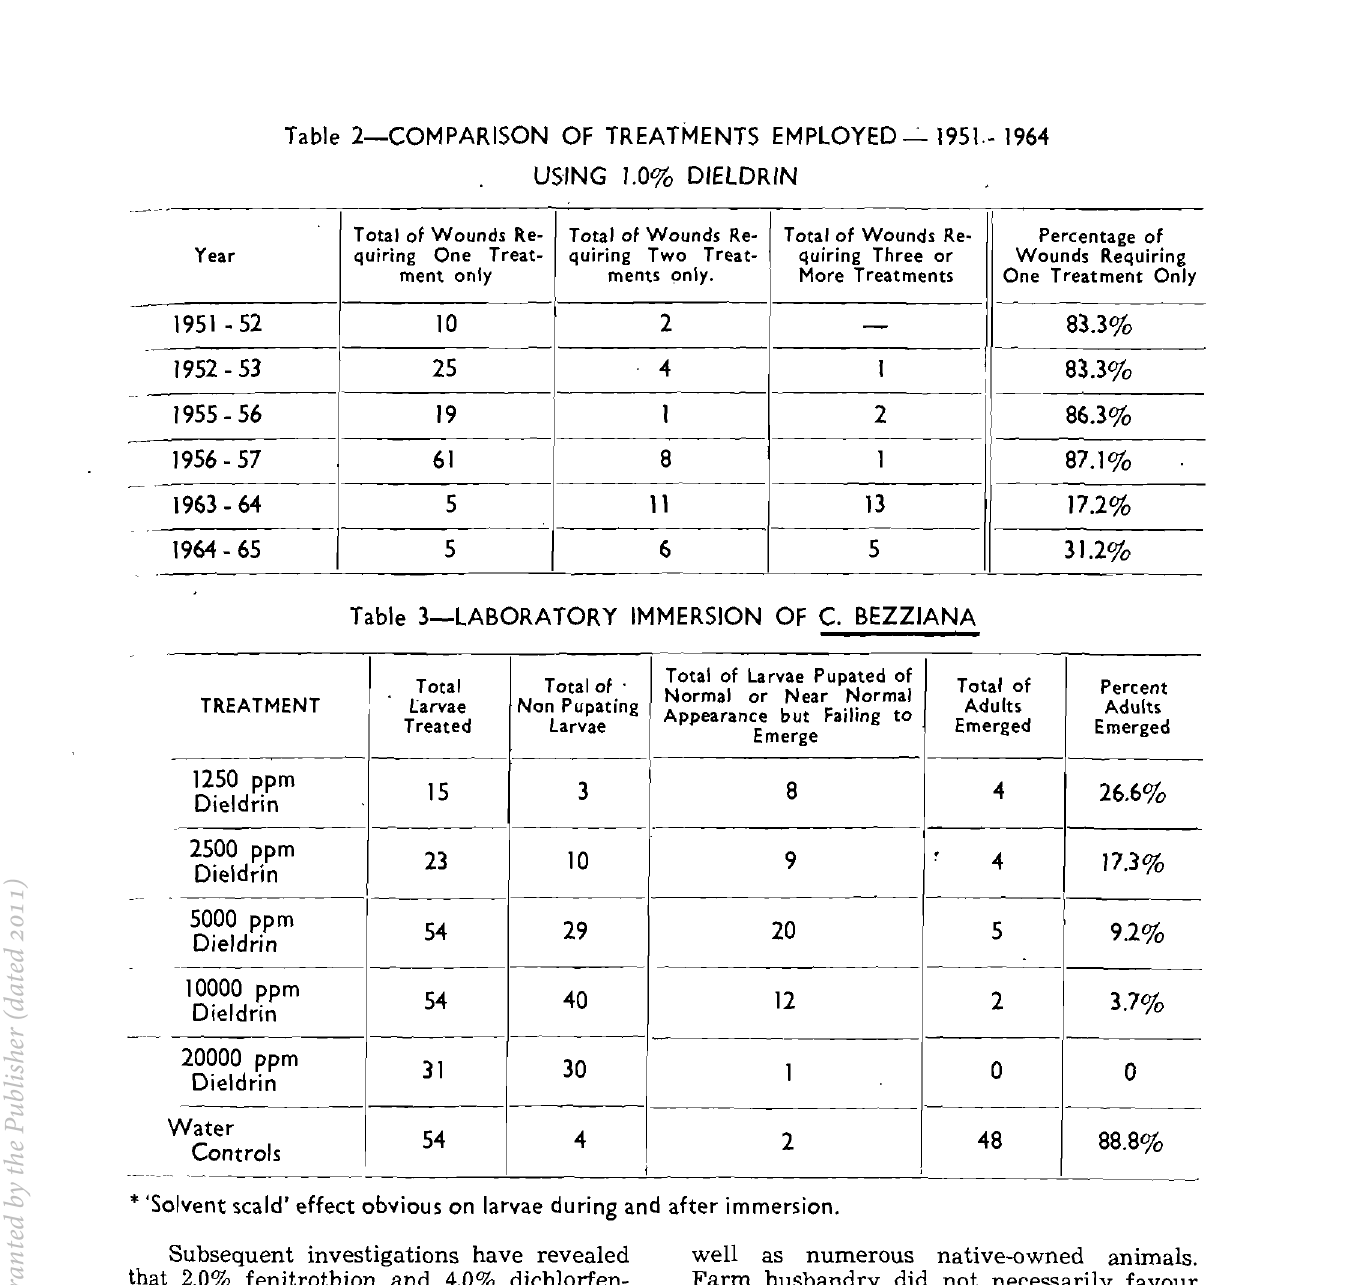
Table 2-COMPARISON OF TREATMENTS EMPLOYED ~ 1951.- 1964